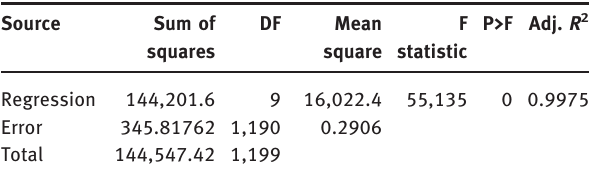
Table 11: Analysis of variance for f 1 ð _ ε , T Þ at the low temperature regions under the ε = 0.002. Source